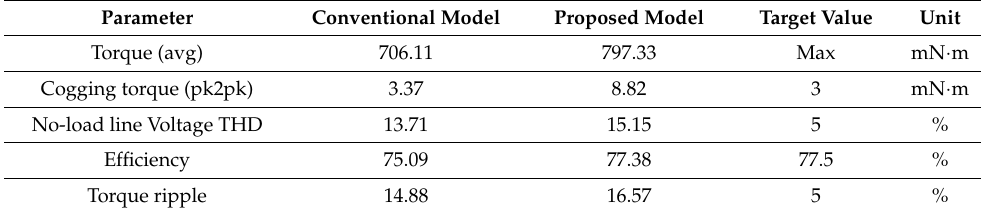
Figure 13. Comparison of the cogging torque (4000 rpm).